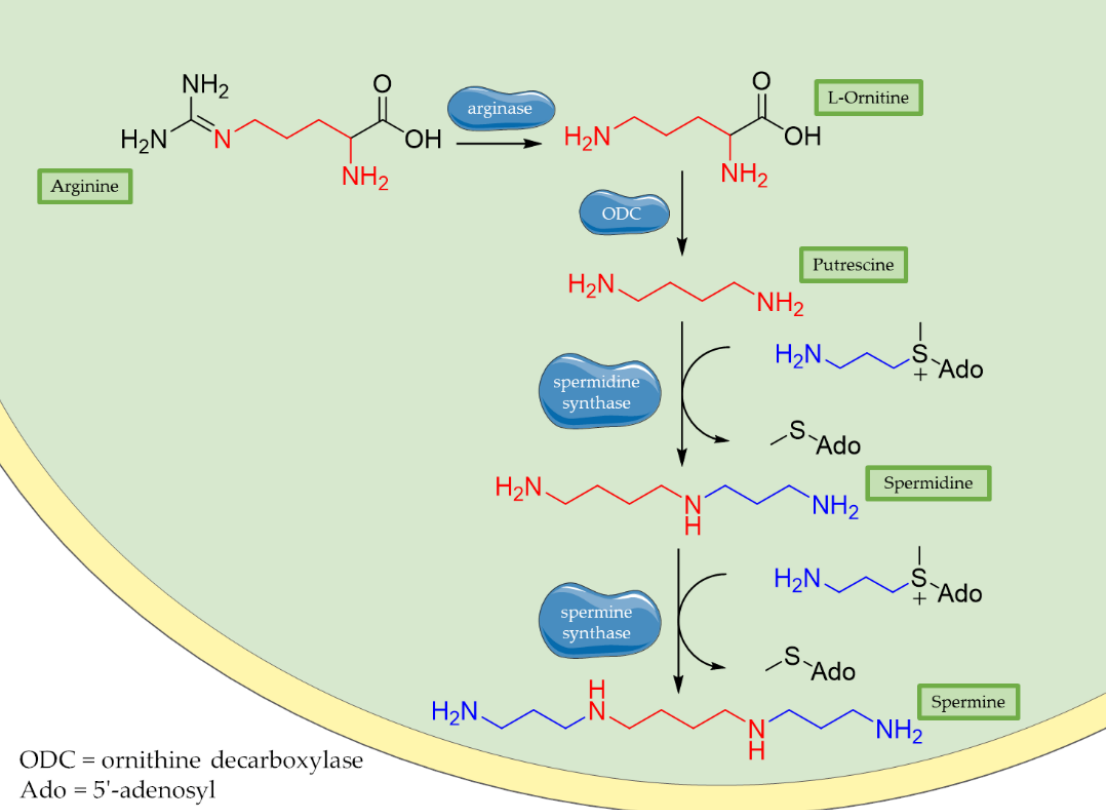
Figure 1. Biosynthesis of polyamines. Briefly, arginase operates the removal of guanidino group from essential amino acid arginine, producing L-ornithine. Then, decarboxylation of L-ornithine mediated by ODC enzyme generates putrescine that is converted to spermidine by spermidine synthase that adds an aminopropyl group to the molecule. Finally, addition of a second aminopropyl moiety to spermidine generates